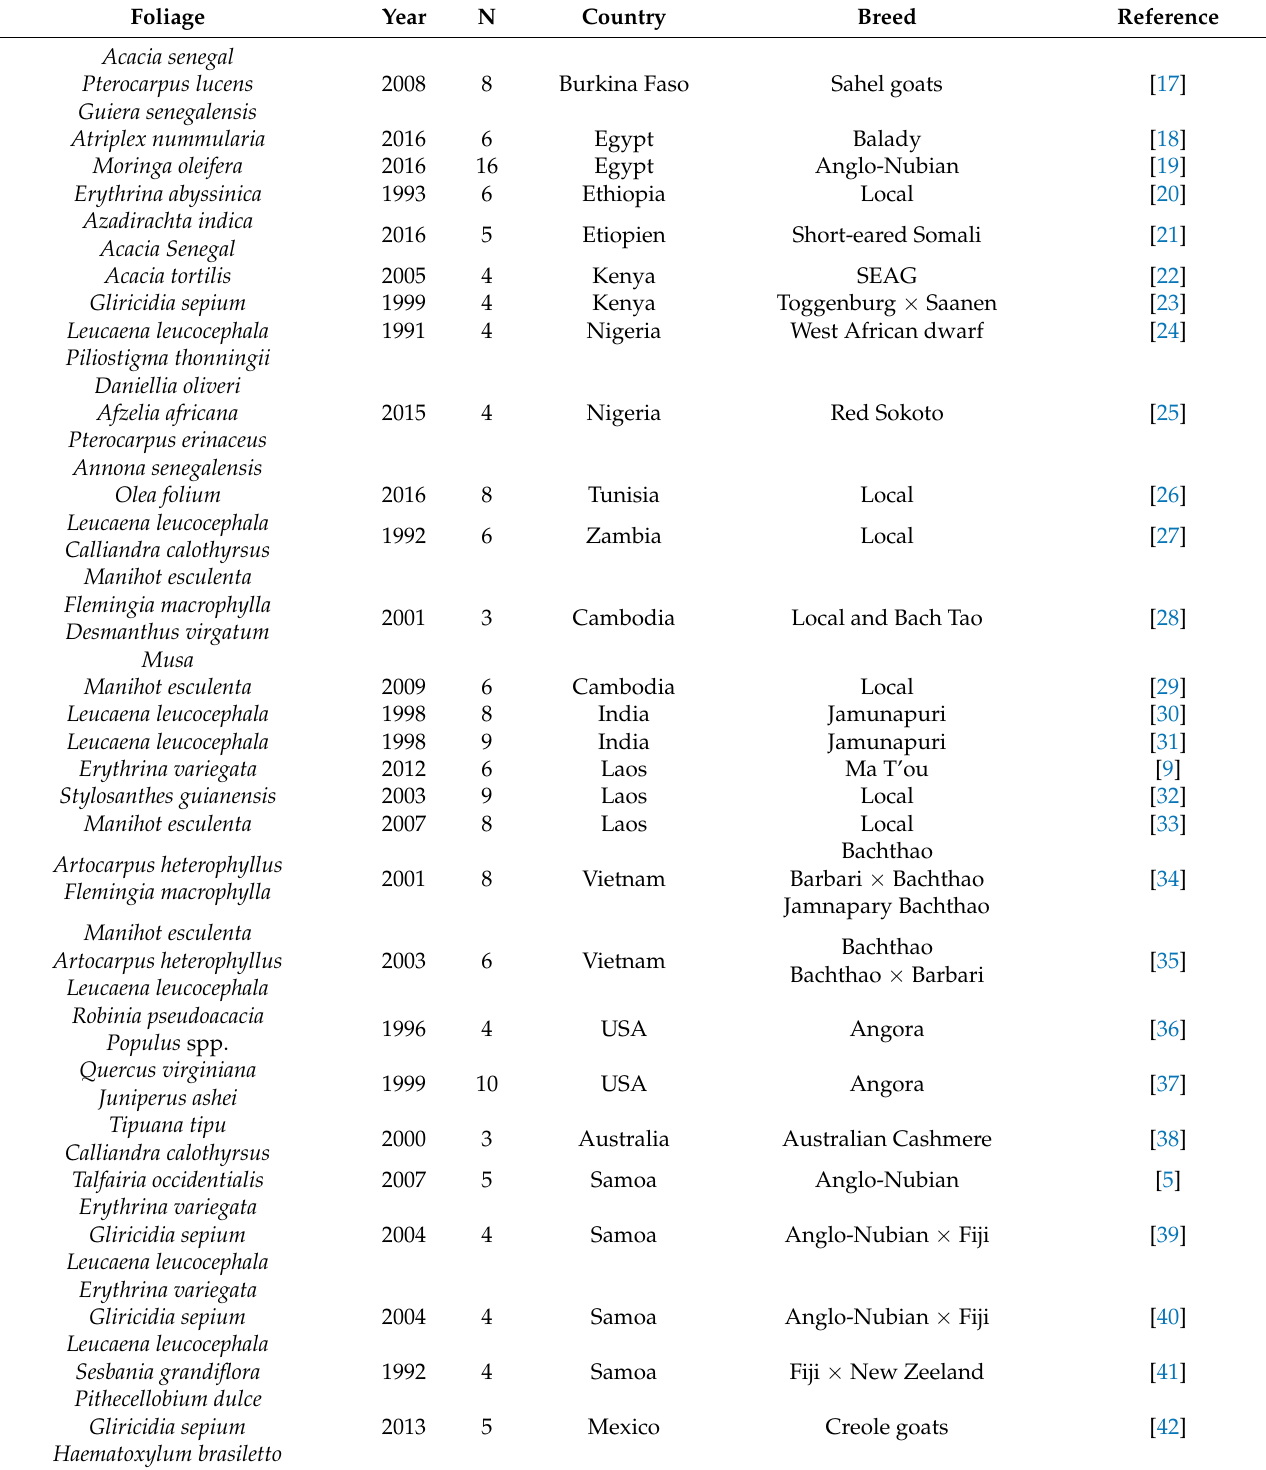
Table 2. Description of